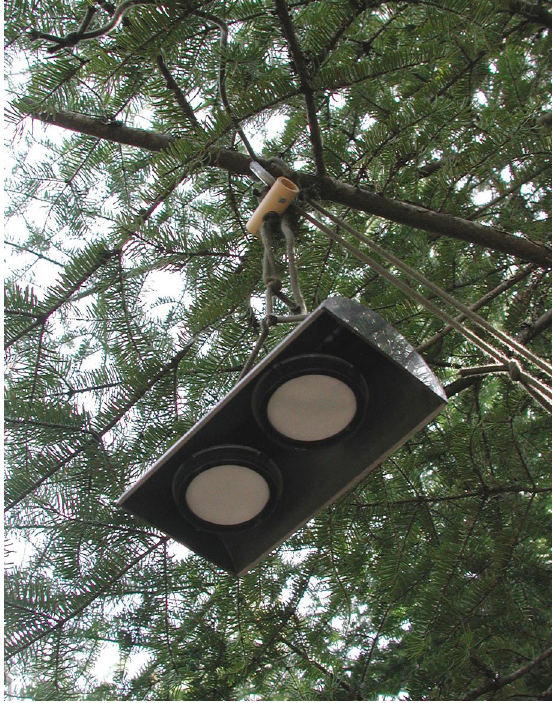
FIGURE 3. Installation of a CanOxy Plate passive ozone sampler in the canopy showing the shelter with installed plates, and the pulley system used to retrieve the sampler to exchange the plates.